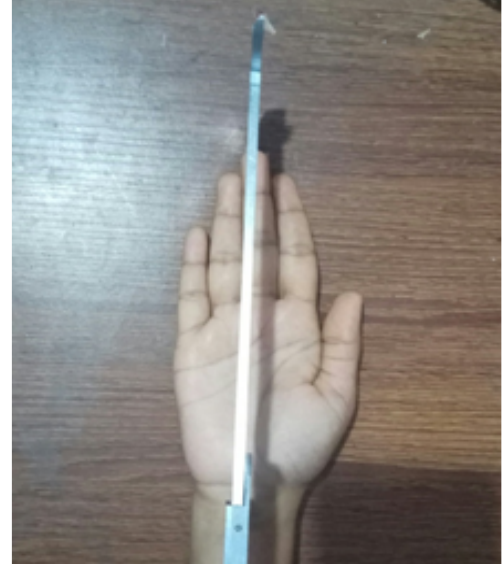
Fig. 2: Measurement of hand